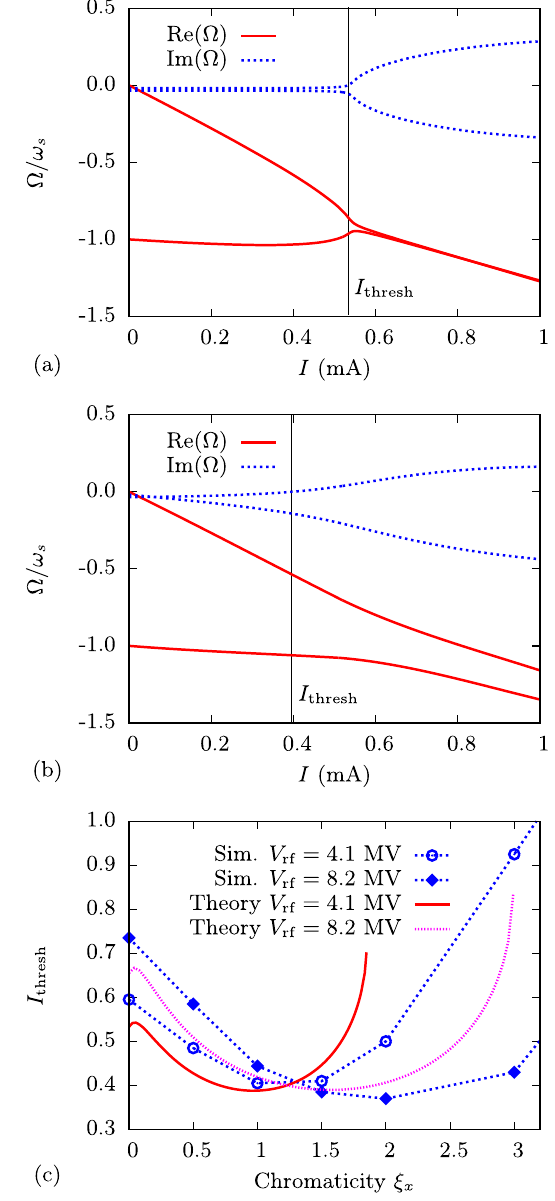
FIG. 2. Real and imaginary parts of Ω for the two-mode theory 0 (a) and ξ 0 . 75 (b). Panel (c) compares the with ξ x ¼ x ¼ instability threshold predicted by theory and simulation for two different rf voltages. The two mode theory follows the 2 πξ σ C ≲ 0 . 7 = α theory reasonably well provided k ξ σ z ¼ x z c R